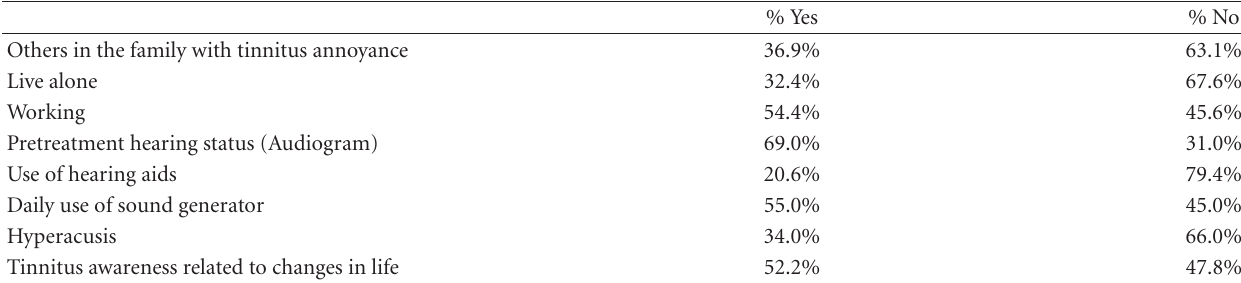
Table 1: Demographic information about the study sample ( N =